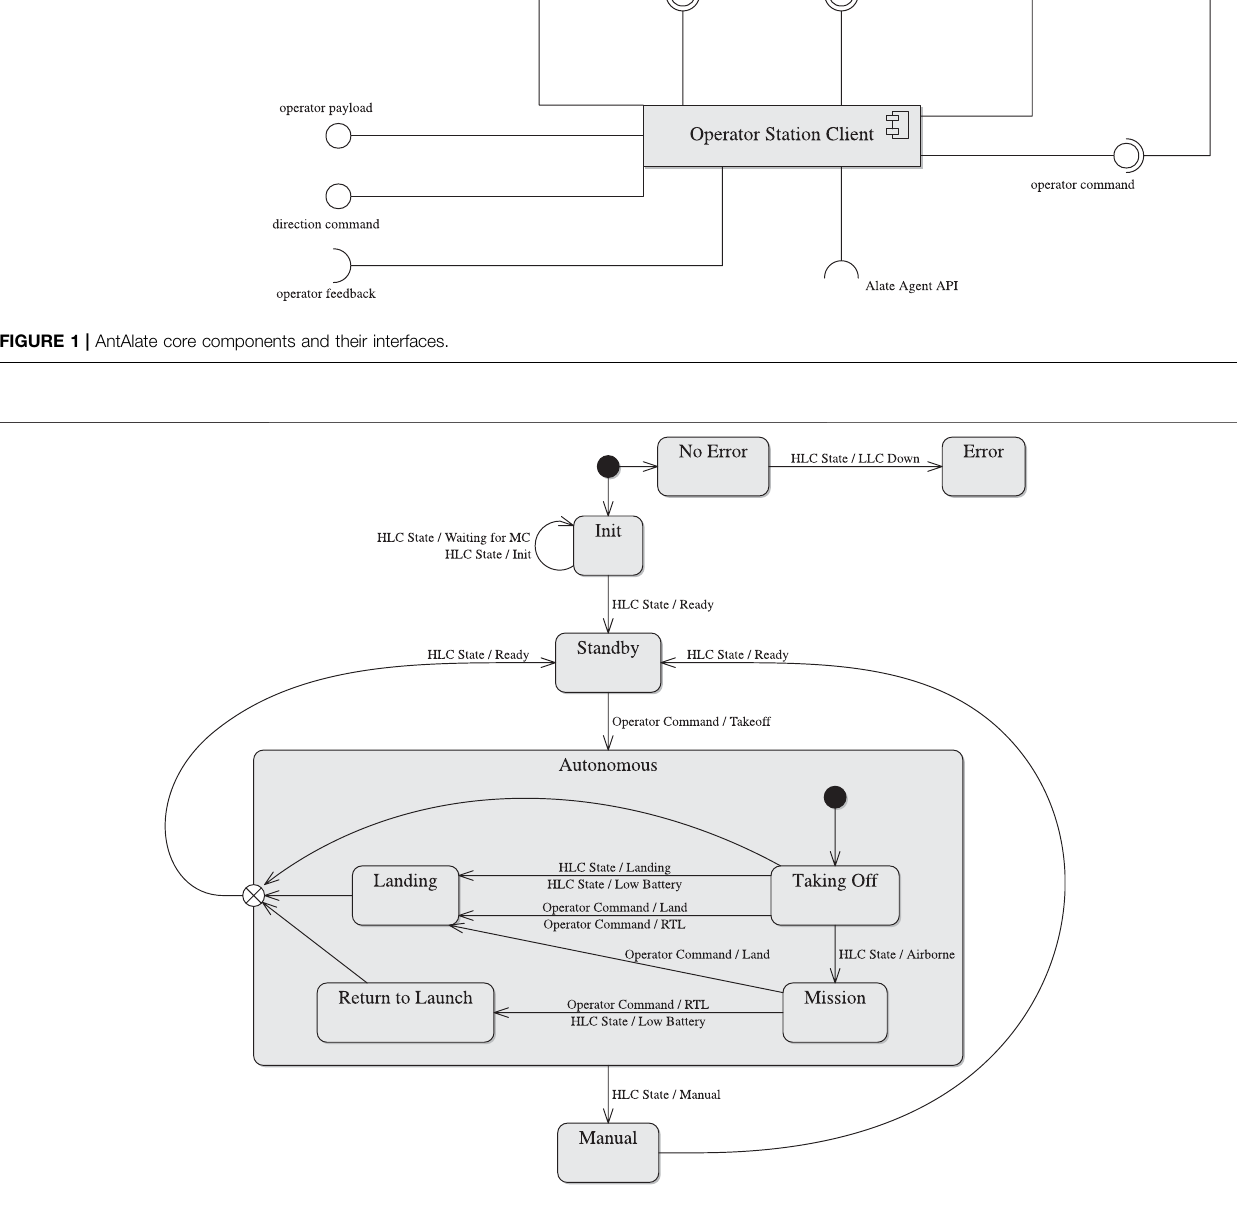
FIGURE 2 | Mission control state machine.